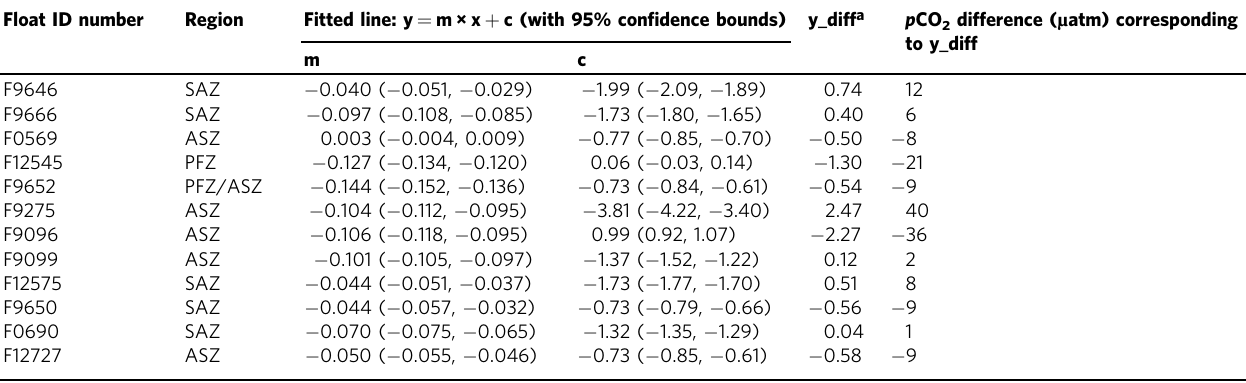
The regions are de fi ned by ocean fronts (Supplementary Fig. 9) following Grayet al. 31 : Subantarctic Zone (SAZ), Polar-Frontal Zone (PFZ), and Antarctic-Southern Zone (ASZ). The fi fth column (y_diff) is the difference in y-intercepts between GLODAP and fl oat data. The sixth column converts the offsets in y-intercept ( µ mol kg − 1 ) to differences in p CO 2 ( µ atm) for an average sea surface temperature of 1°C. a GLODAP-derived y-intercepts minus fl oat-derived y-intercepts; negative (positive) values mean that the fl oat y-intercept is greater (lower) than the GLODAP